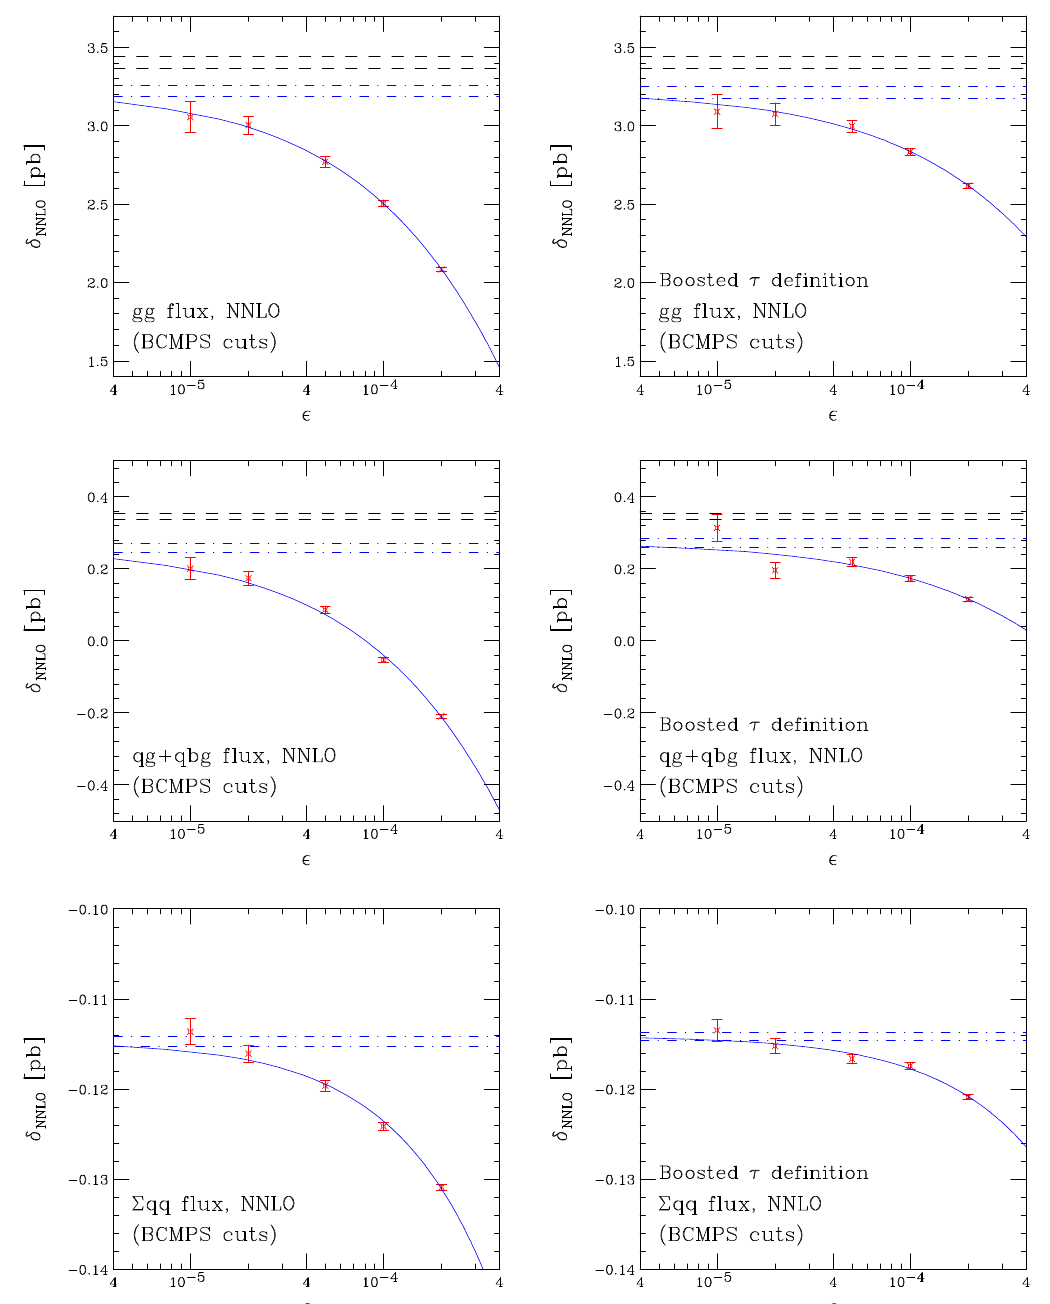
Figure 7 . (cid:28) -dependence of the NNLO coe(cid:14)cient for the gg , qg +(cid:22) qg and four-quark partonic channels using the setup of BCMPS. The plots on the left-hand side show the results with T 1 computed in the hadronic c.o.m. while those on the right are obtained using the boosted de(cid:12)nition. The black dashed lines indicate the BCMPS result, including the uncertainty, and the bands enclosed by the blue dot-dashed lines show the error on the asymptotic value obtained from the (cid:12)tted blue curve.